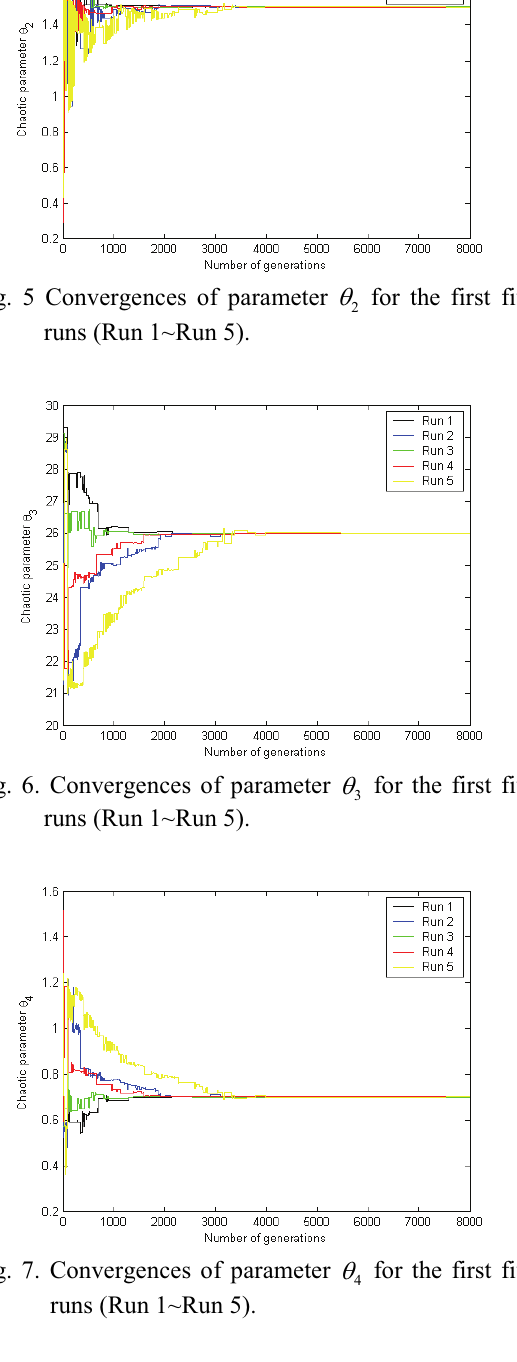
(cid:84) for the first runs 1